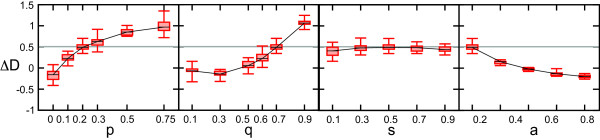
ΔD values for the extended DD model under different parameter conditions. Increase in values of p and q and decrease of a lead to higher ΔD values in the network, divergence symmetry s has very little effect. Default parameter conditions are p = 0.2, q = 0.7, s = 0.5, a = 0.2, each plot shows ΔD values when one of these parameters is varied while the others are kept at default values (for full parameter sweeps we refer to Figure S16). The gray line is the ΔD value of the yeast LC PIN. Boxes show the .25 and .75 percentile of 20 runs, the error bars show the extreme values and the black line is the mean of 20 runs.